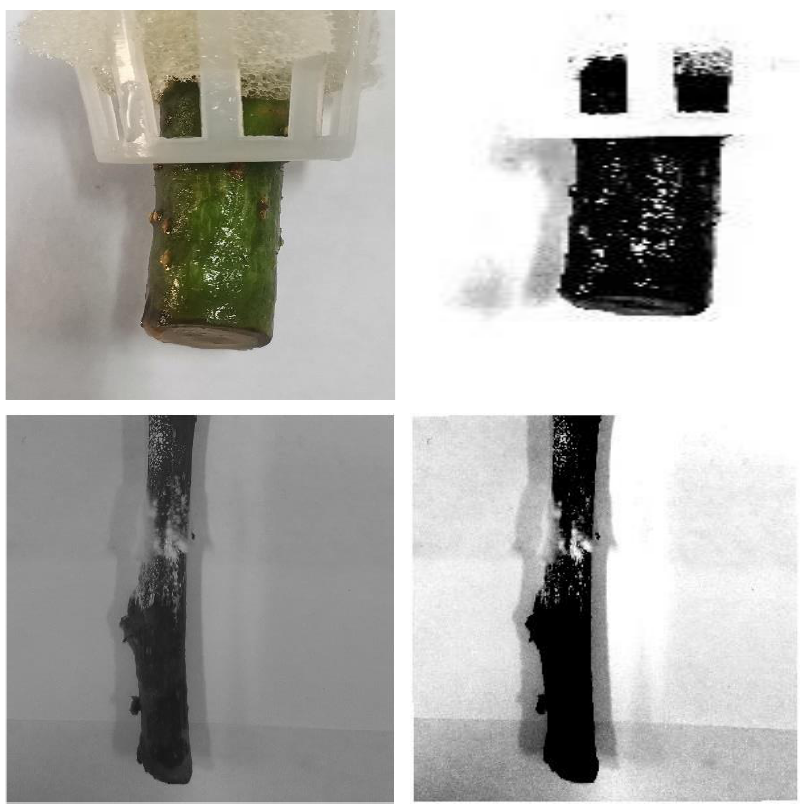
Figure 5. Comparison of the original image and the image after image enhancement. Mildew on mulberry roots was characterized by white mildew on the surface of the plant roots, as shown in Figure 6. If the mildewed cuttings were not treated in time, the mildew would spread and affect the healthy cuttings adjacent to them; thus, the health condition of the plants should be quickly and accurately detected and